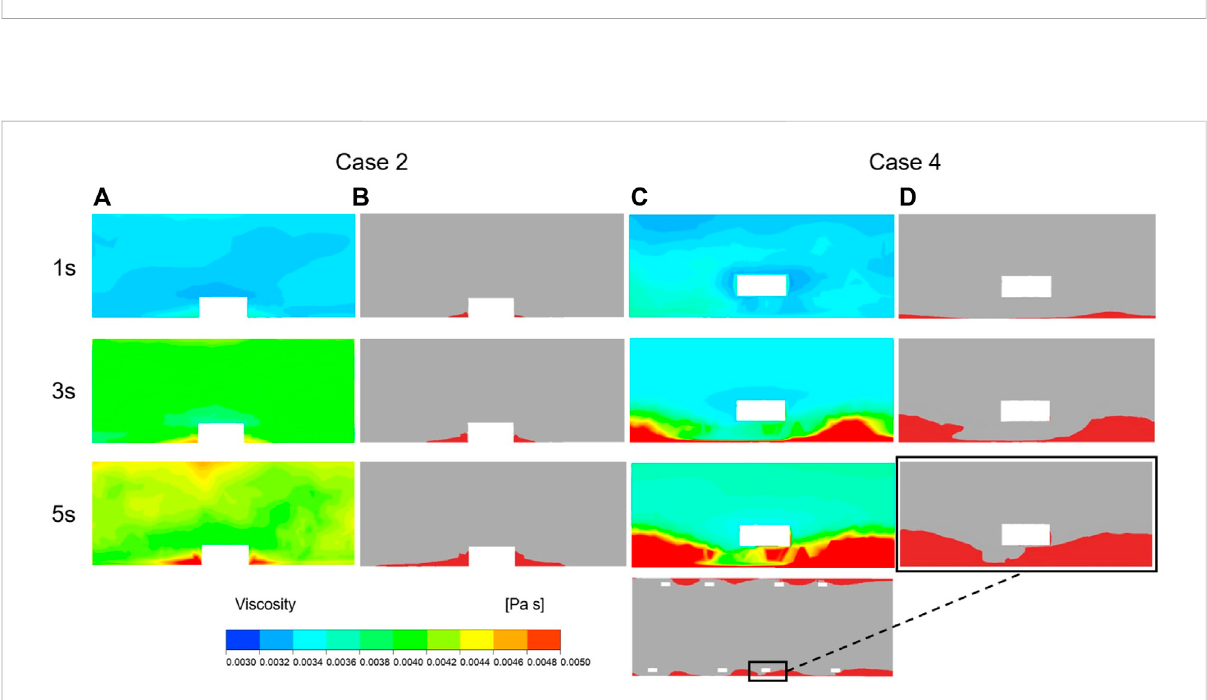
FIGURE 8 Viscosityandthrombusdistributiononthelongitudinalsectionsofcase2andcase4atthreetime pointsofsimulation. (A) Viscositydistribution ofCase 2after 1 s, 3 sand 5 sof thrombuscalculation. (B) ThrombusdistributionofCase 2after 1 s, 3 sand 5 sof thrombuscalculation. (C) Viscosity distribution of Case 4 after 1 s, 3 s and 5 s of thrombus calculation. (D) Thrombus distribution of Case 4 after 1 s, 3 s and 5 s of thrombus